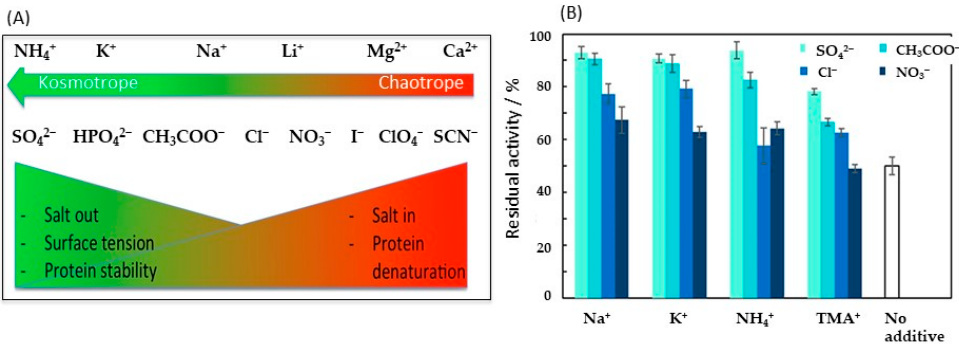
Figure 3. Salt effect on enzyme stability. ( A ) Hofmeister series and effect on protein properties. ( B ) Stabilization effect of kosmotropic anions and cations on Aspergillus terreus GDH. Residual activity after 1 h incubation at 50 °C as a function of added anions and cations. Reproduced with permission from [65].